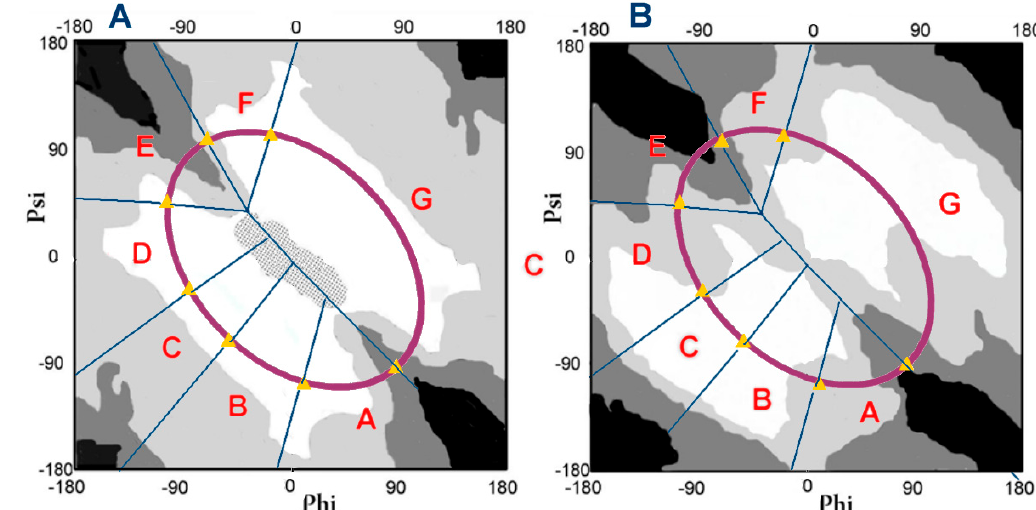
Figure 8. Distribution map; A —radius of curvature; B —the V angle; with a distinguished elliptical path expressing the optimal relationship between the radius of curvature and the V-angle. Zones resulting from the presence of local maxima of the probability of occurrence of the angles Phi and Psi are also marked.